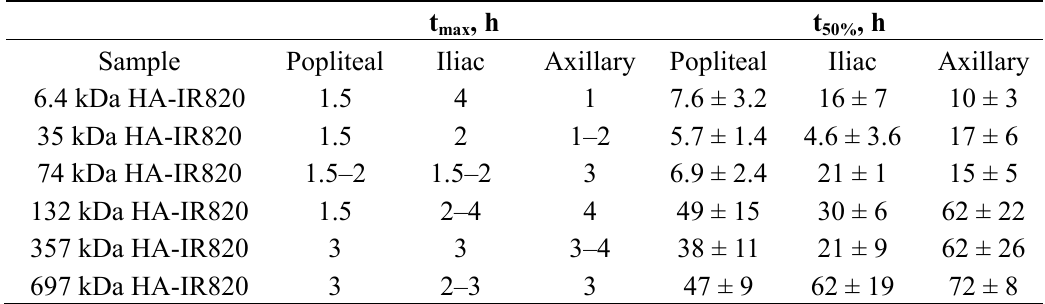
Table 4. The t and t of the lymphatic drainage to the popliteal, iliac, and max 50%